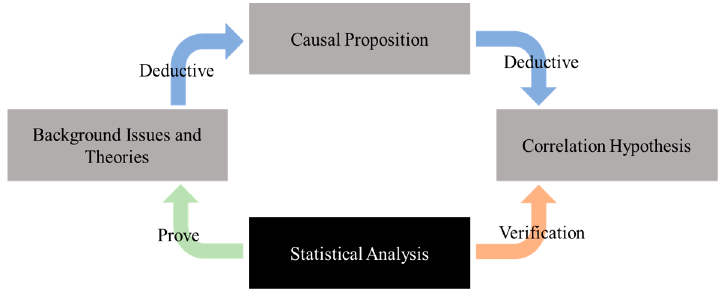
Figure 1. The process of validating causality.